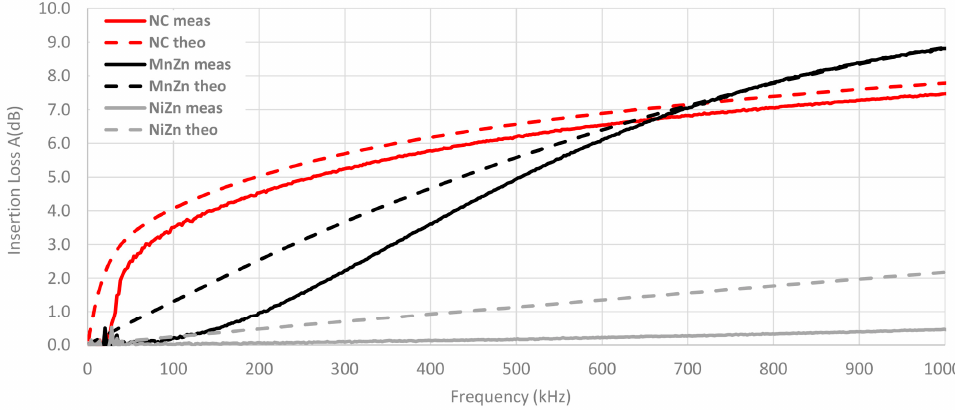
Figure 21. Comparison between experimental and theoretical insertion loss of different cable ferrites depending on the material composition by winding 1 turn at higher frequencies.